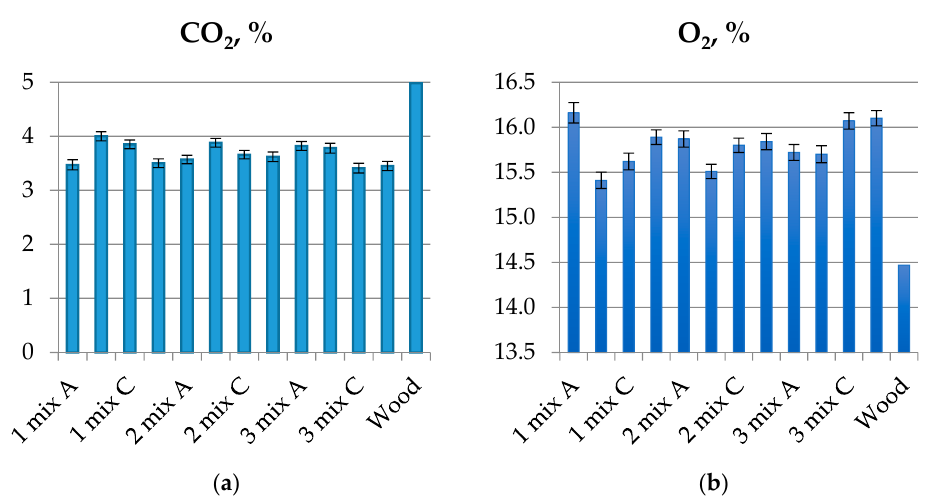
Figure 6. CO 2 ( a ) and O 2 ( b ) emissions from burning of granulated faba bean waste and potato peels.